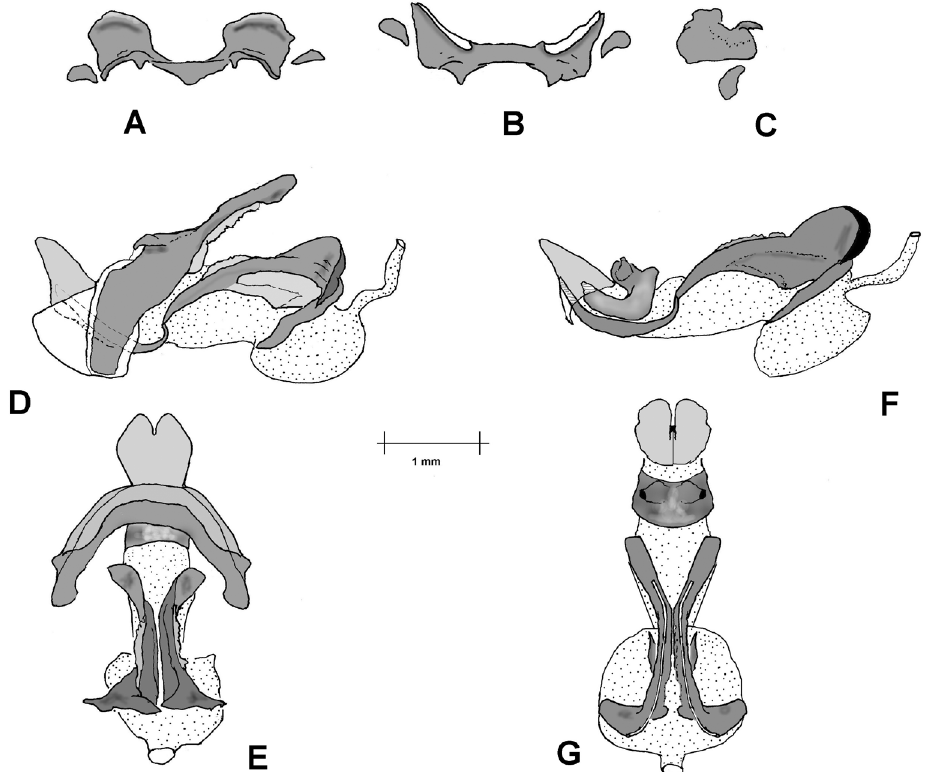
Fig. 5. Aresceutica nguruensis sp. n., phallus. A. Epiphallus, axial view; B. Epiphallus and oval sclerites, dorsal view; C. Epiphallus, lateral view; D. Phallic complex after removal of epiphallus and epiphallic membrane, lateral view; E. As in D, but dorsal view; F. Endophallus and arch, lateral view; G. As in F, but dorsal view.